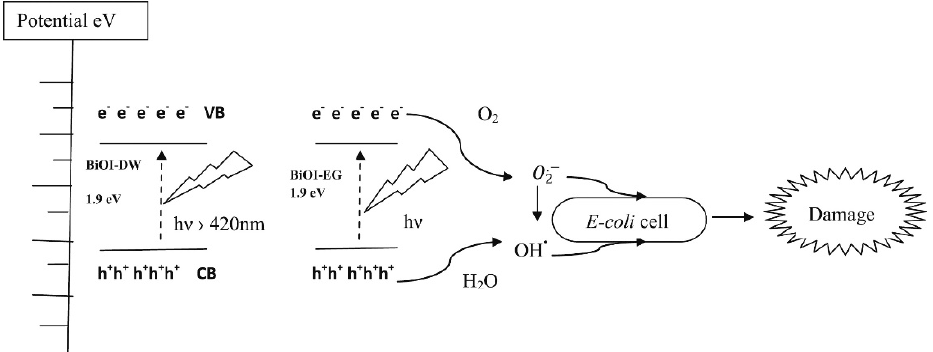
Figure 6. Schematic illustration of energy bands, electron–hole separation and damage mechanism for E. coli . Adapted with permission from Jamil et al. [76] .